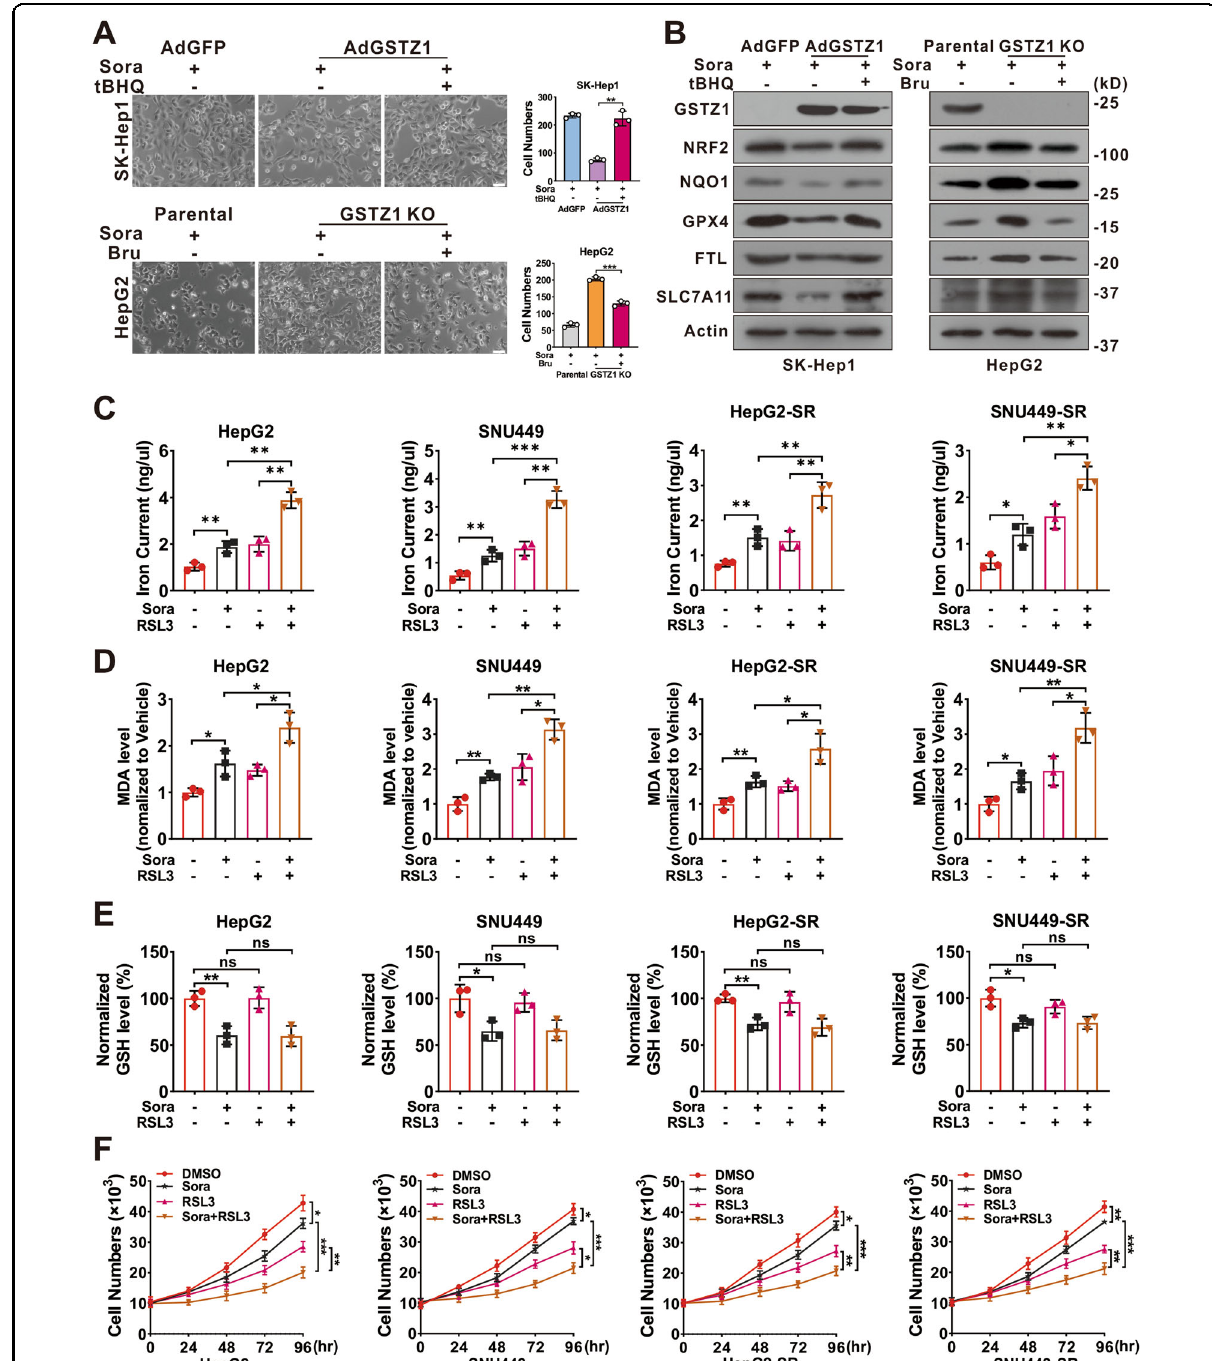
Fig. 6 RSL3 enhances the sensitivity of GSTZ1-KO and sorafenib-resistant cells to sorafenib. A , B Morphological changes ( A ) and protein level ( B ) of ferroptosis-related genes. GSTZ1-OE SK-Hep1 cells were treated with sorafenib alone or in combination with tBHQ (top). GSTZ1-KO HepG2 cells were treated with sorafenib alone or in combination with Bru (bottom). Scale bar = 10 μ m. C – E Iron ( C ), MDA ( D ), and GSH ( E ) levels in GSTZ1-KO and sorafenib-resistant cells treated with sorafenib alone or in combination with RSL3 (500 nM for 24 h). F Cell growth curve of GSTZ1-KO and sorafenib- resistant cells treated with sorafenib alone or in combination with RSL3. RSL3: Ras-selective lethal small molecule 3, tBHQ tertiary butylhydroquinone, Bru brusatol, DMSO dimethyl sulfoxide, Sora sorafenib, MDA malondialdehyde. Values represent the mean ± SD ( n = 3). * p < 0.05, ** p < 0.01, *** p < 0.001, Student ’ s t -test (two